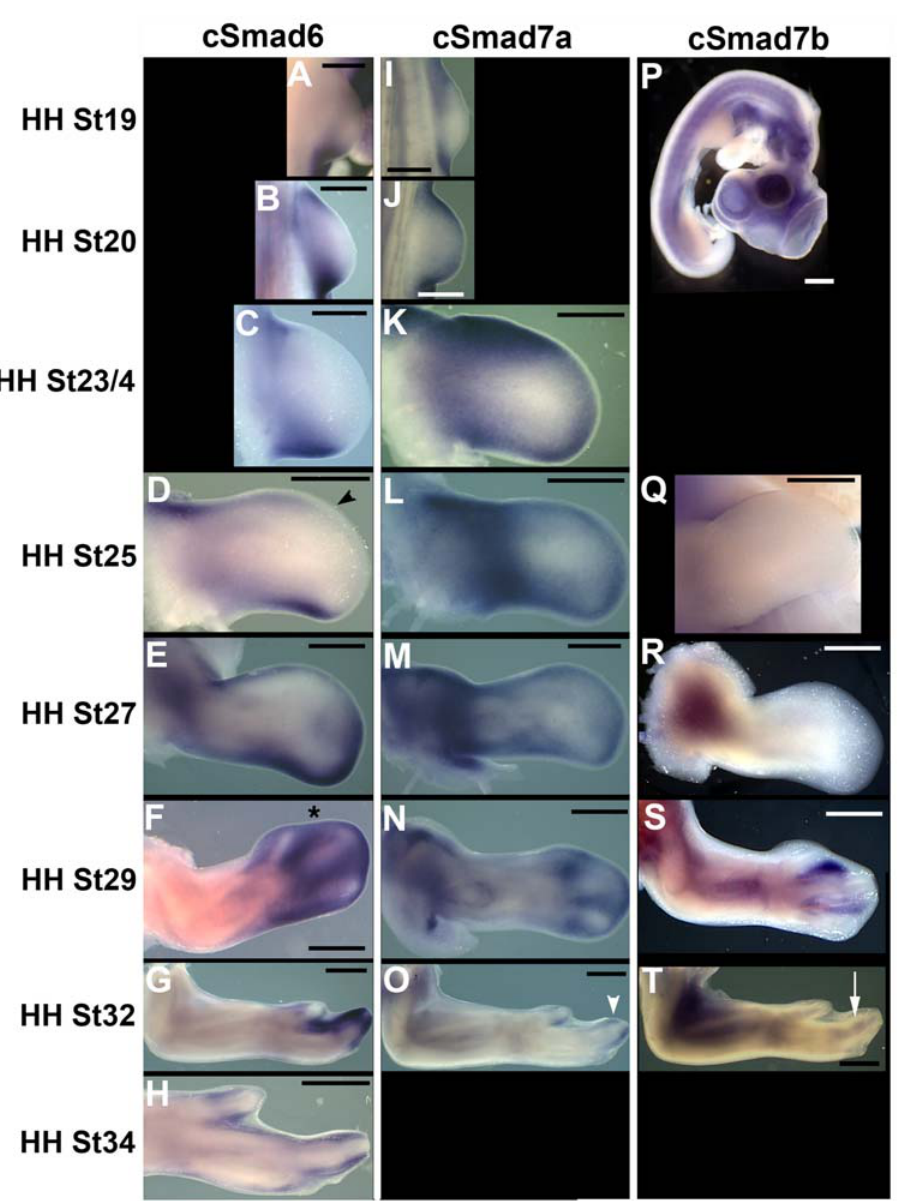
Figure 2. Negative Smad gene expression patterns during chick forelimb development. Expression patterns of cSmad6 (A–H), cSmad7a (I– O) and cSmad7b (P–T) in the developing chick forelimb. Developmental stages as indicated. Note cSmad6 expression domain extends as development proceeds to beneath apical ridge (black arrowhead). Expression of both cSmad6 and cSmad7a is present in distal mesenchyme before being restricted to interdigital regions (black asterisk), then further restricted to areas around the digit tip (white arrowhead). cSmad7b is not expressed in the forelimb mesenchyme until HH st29/30 and is then restricted to the cartilage condensations (white arrow). Signal in body and head in (P) is non-specific background. Images are of limb dorsal surface. Anterior to the top; distal to the right. Scale bars indicate 500 m m.